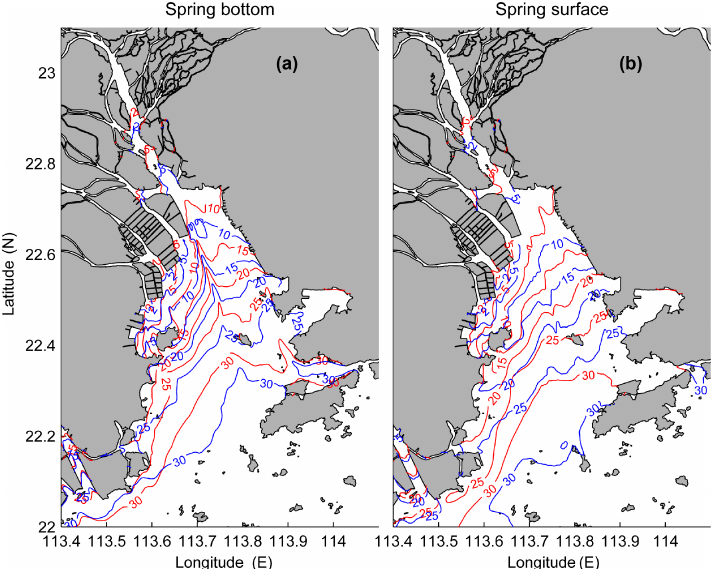
Figure 6. Comparison of 50h averaged salinity contours for Cases 1 and 2. Panel (a) shows the bottom salinity during a spring tide, while panel (b) shows the surface salinity during the spring tide. The blue contour stands for case 1, while the red contour is case